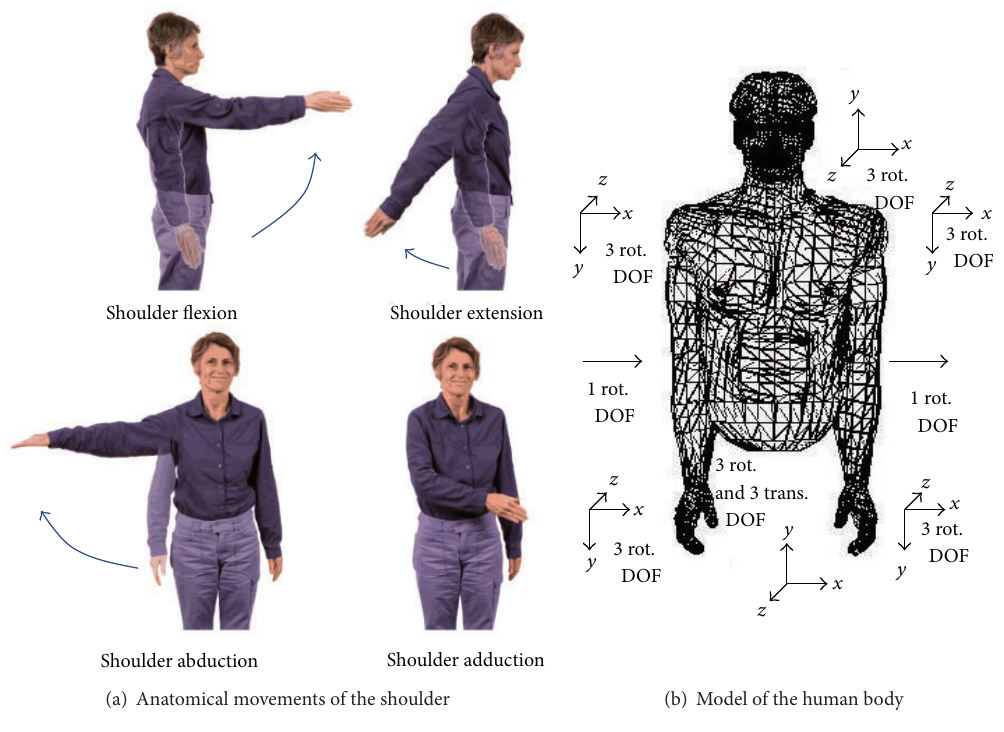
Figure 4: Shoulder movements and human